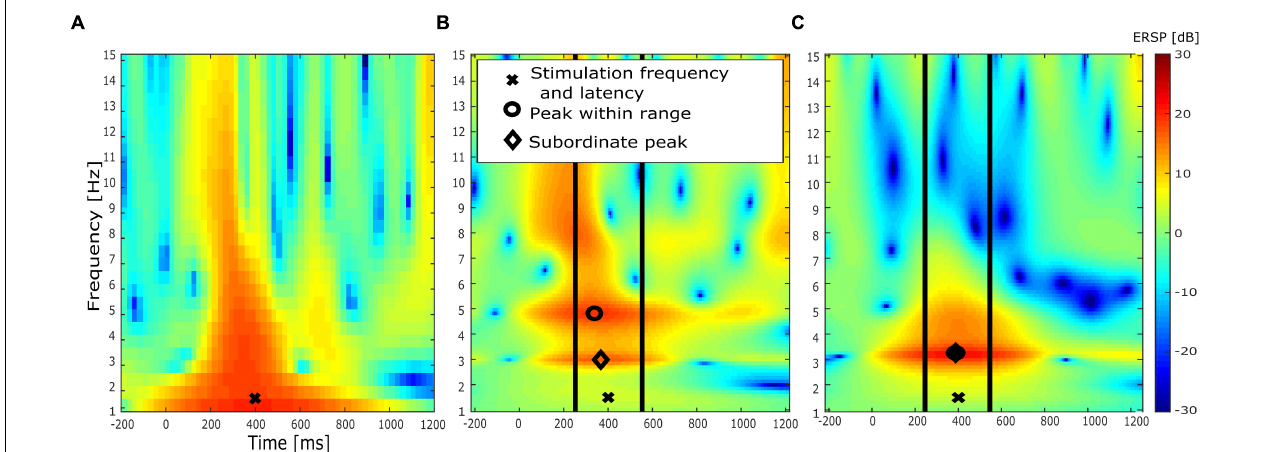
FIGURE 3 | ERSP analysis of exemplary subject. (A) ERSP of EEG baseline block (block 1) after preliminary analysis during experiment with a frequency resolution of 0.5 Hz. “X” indicates maximum ERSP value. The frequency at which this value occurred was used as stimulation frequency. (B) ERSP of EEG baseline block (block 1) after elaborated EEG preprocessing and with a higher frequency resolution of 0.14 Hz. Symbols mark respective peak of three separate analysis approaches. “X” indicates stimulation parameters determined in the preliminary analysis shown in (A) . The first analysis compared the ERSP value at the stimulation parameters determined in (A) , marked by “X.” The second analysis is marked by the circle, indicating the maximum ERSP value within a time range of previously determined P300 latency ± 150 ms (vertical lines). Finally, the diamond marks ERSP peak located closest to stimulation frequency within the same time range. (C) ERSP of post-stimulation EEG block (block 3) after elaborated EEG